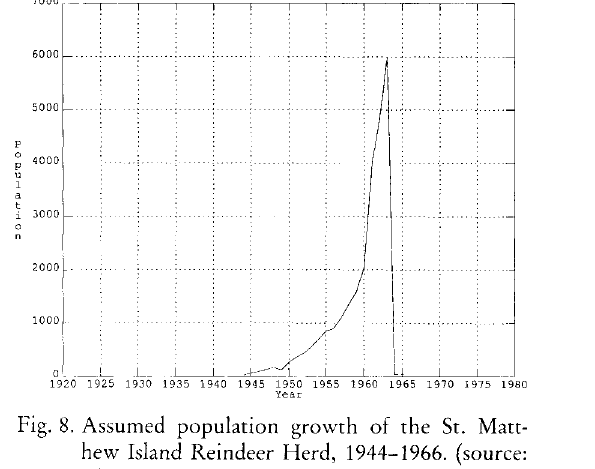
Fig. 8. Assumed population growth of the St. Matt hew Island Reindeer Herd, 1944-1966. (source: Klein